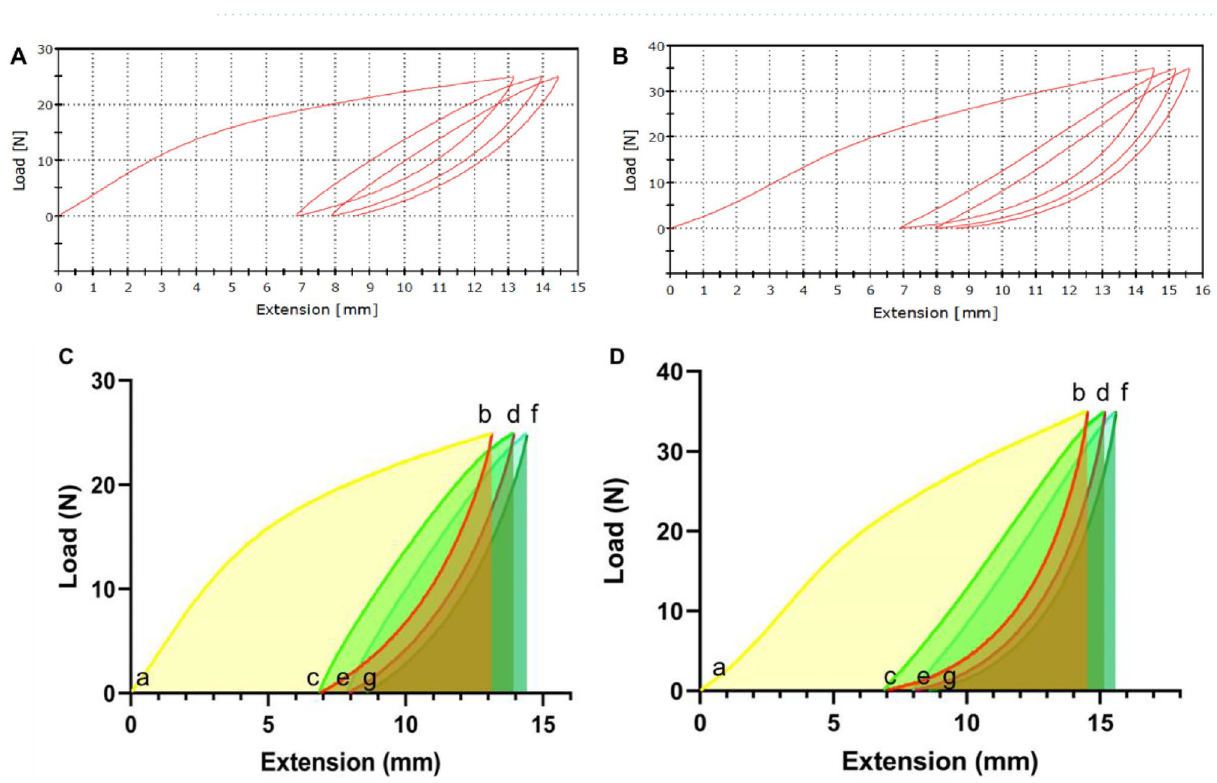
Figure 11. Mechanical properties of approved face masks. ( A ) maximum load. ( B ) stretch to failure.